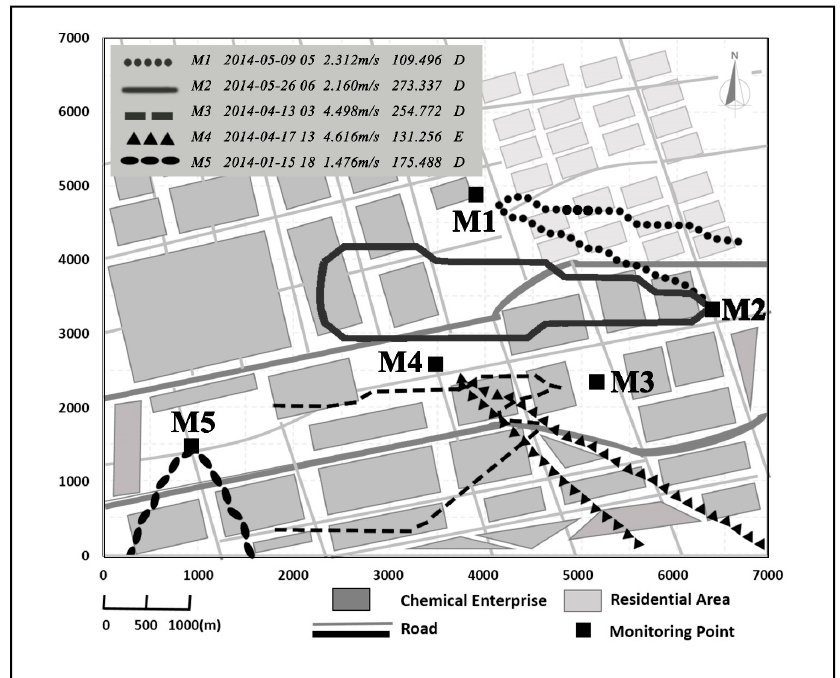
Figure 8. Typical source area results at each monitoring site.